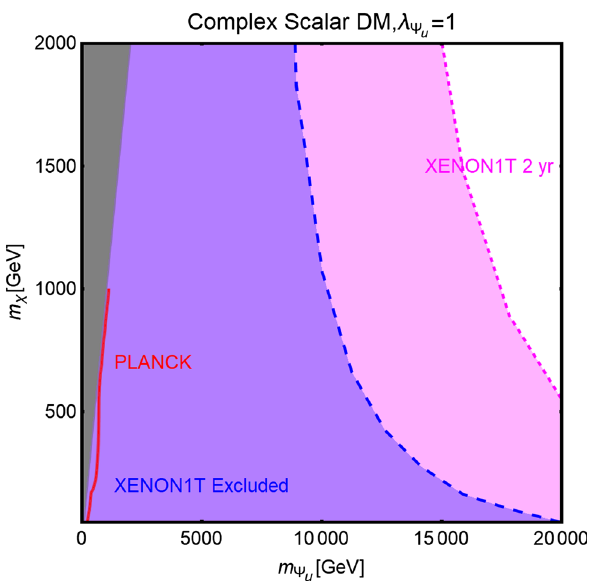
Fig. 16 Combined constraints for a complex scalar DM χ coupled withtheright-chiralup-typequarksthroughaDiracfermionict-channel , m χ ) and mediator Ψ u . The results are in the bi-dimensional plane ( m Ψ u the coupling λ Ψ has been set to 1. The red curve corresponds to the u contour of correct DM relic density. The blue region is excluded by the current constraints while the magenta region will be excluded in the absence of signals from XENON1T after 2 years of exposure. The grey region corresponds to m χ > m Ψ where the DM is not cosmologically u